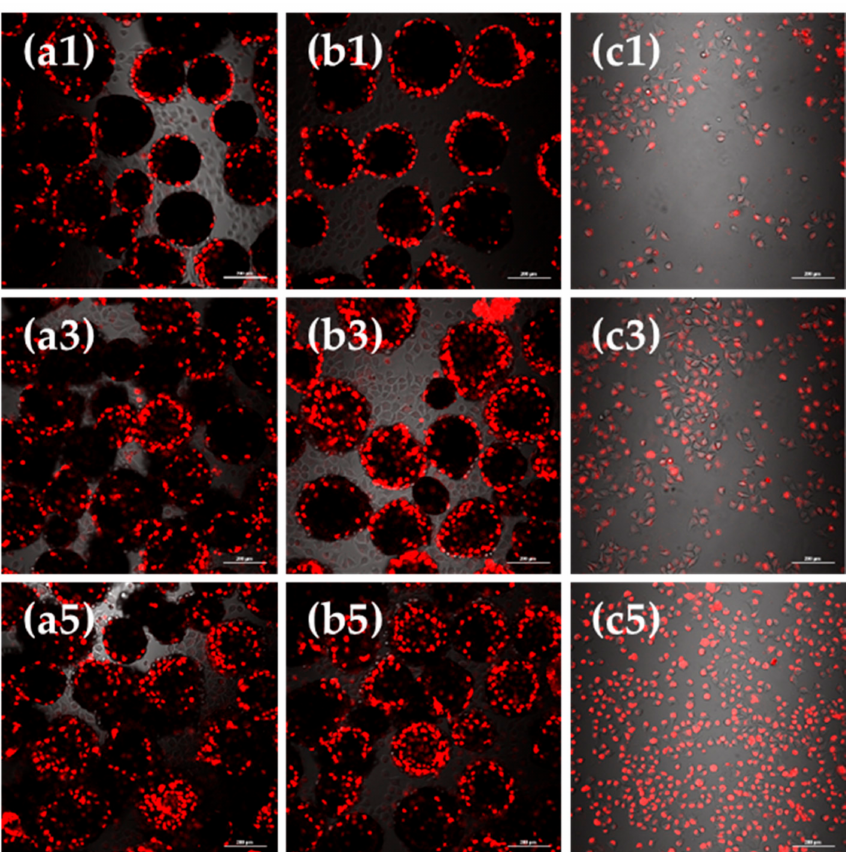
Figure 4. CLSM images of L929 cells cultured on ( a ) bFGF-unloaded SF microspheres; ( b ) bFGF-loaded SF microspheres; ( c ) culture plates (control) for 1, 3 and 5 days. Scale bars: 200 µ